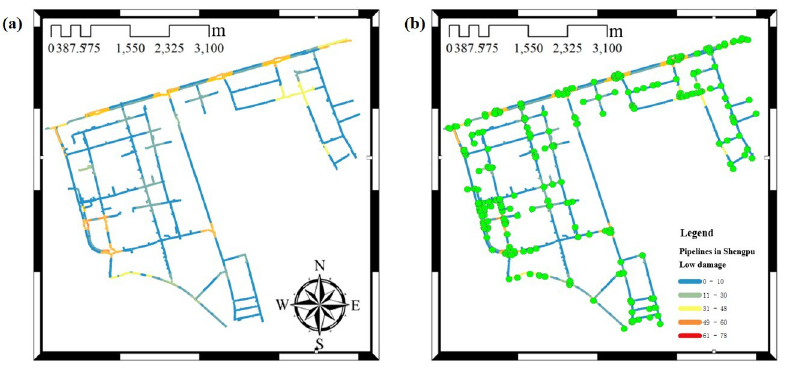
Fig 15. Low damage results from the connectivity to the water supply pipeline network in Shengpu subregion without considering the nodes. (a) Not considering the nodes, (b) Not considering the nodes (including the nodes). (Republished under a CC BY license, with permission from Suzhou Industrial Park Qingyuan Huayan Water Co. LTD, original copyright 2019).